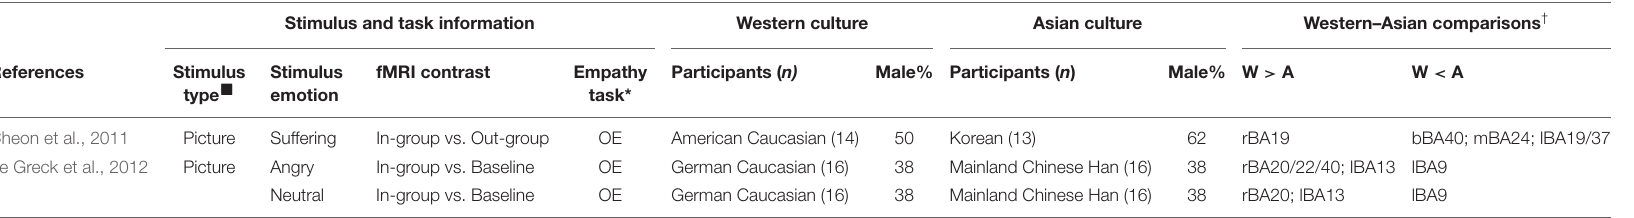
TABLE 3 | A literature review of Western-Asian cross-cultural comparisons of state empathy using fMRI.